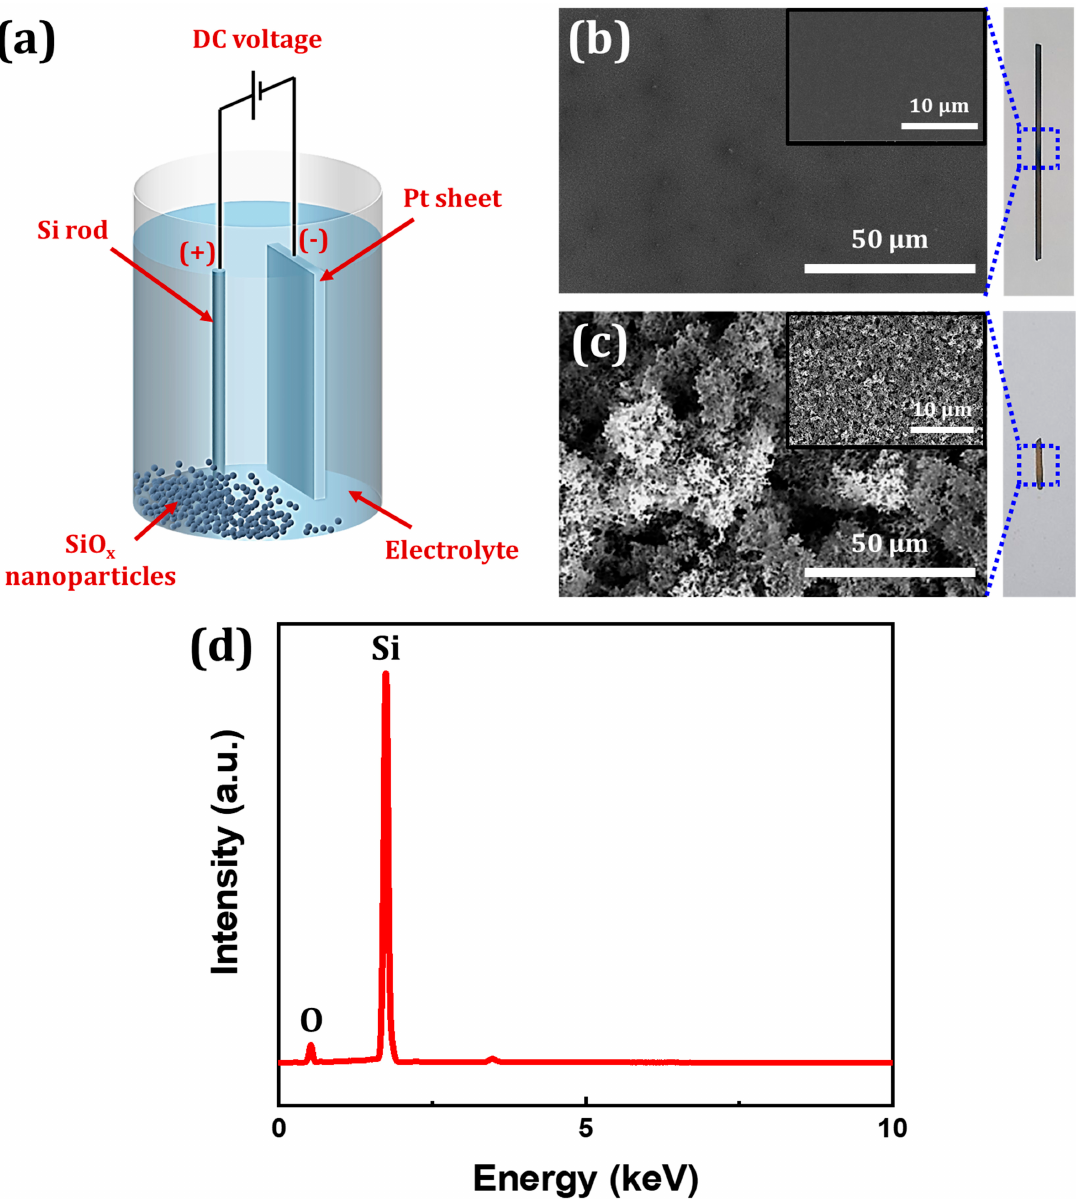
Figure 1. ( a ) An illustration showing the two-electrode anodization process for SiO x nanoparticle (NP) synthesis. FESEM images of a Si rod surface ( b ) before and ( c ) after anodization (digital images shown on the right). ( d ) EDX spectrum of the Si rod surface after anodization at a constant voltage and temperature of 7.5 V and 10 °C, respectively.